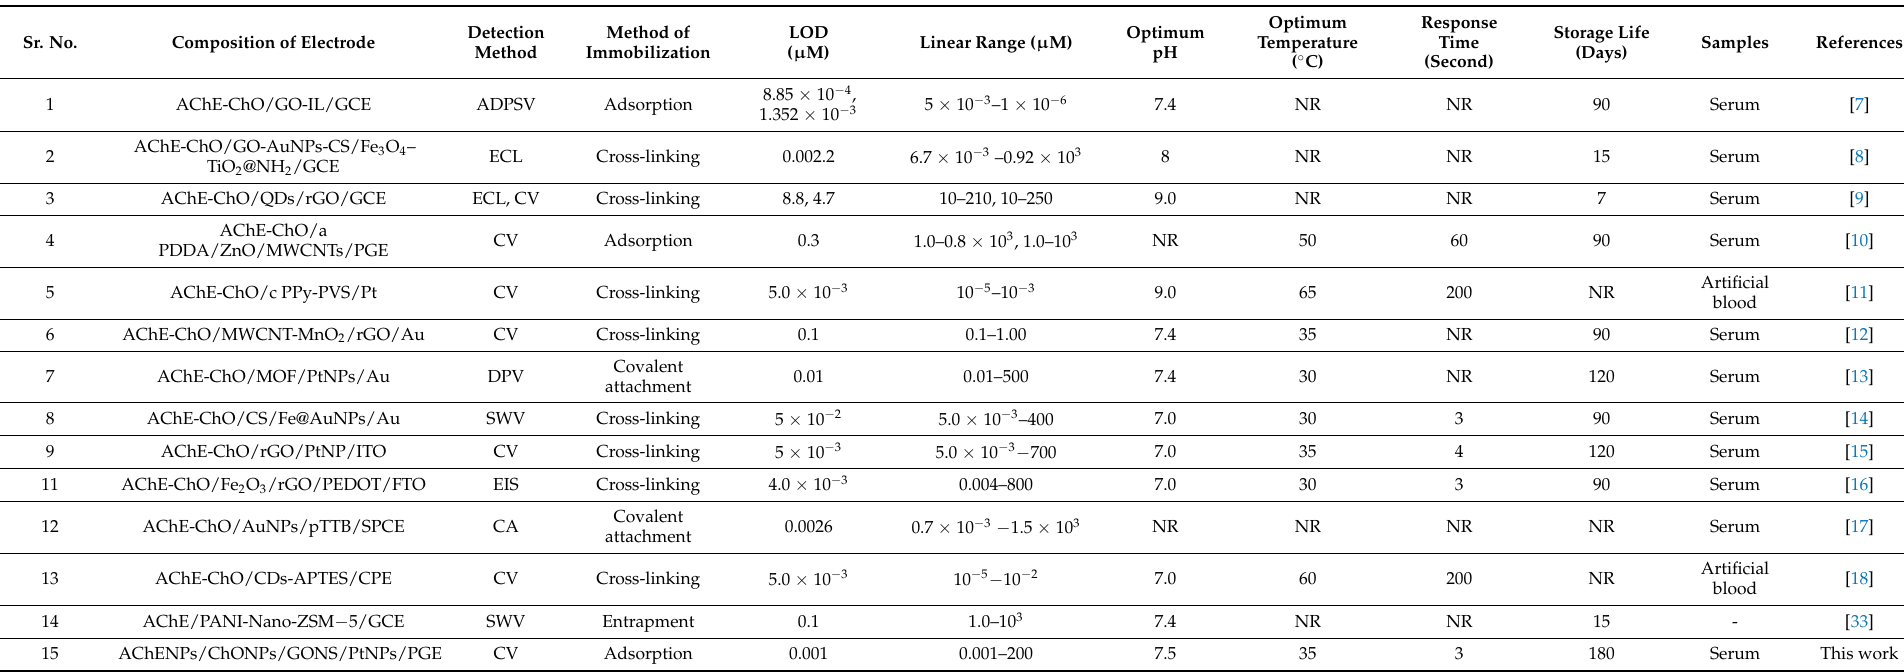
Table 2. Comparison of various electrochemical